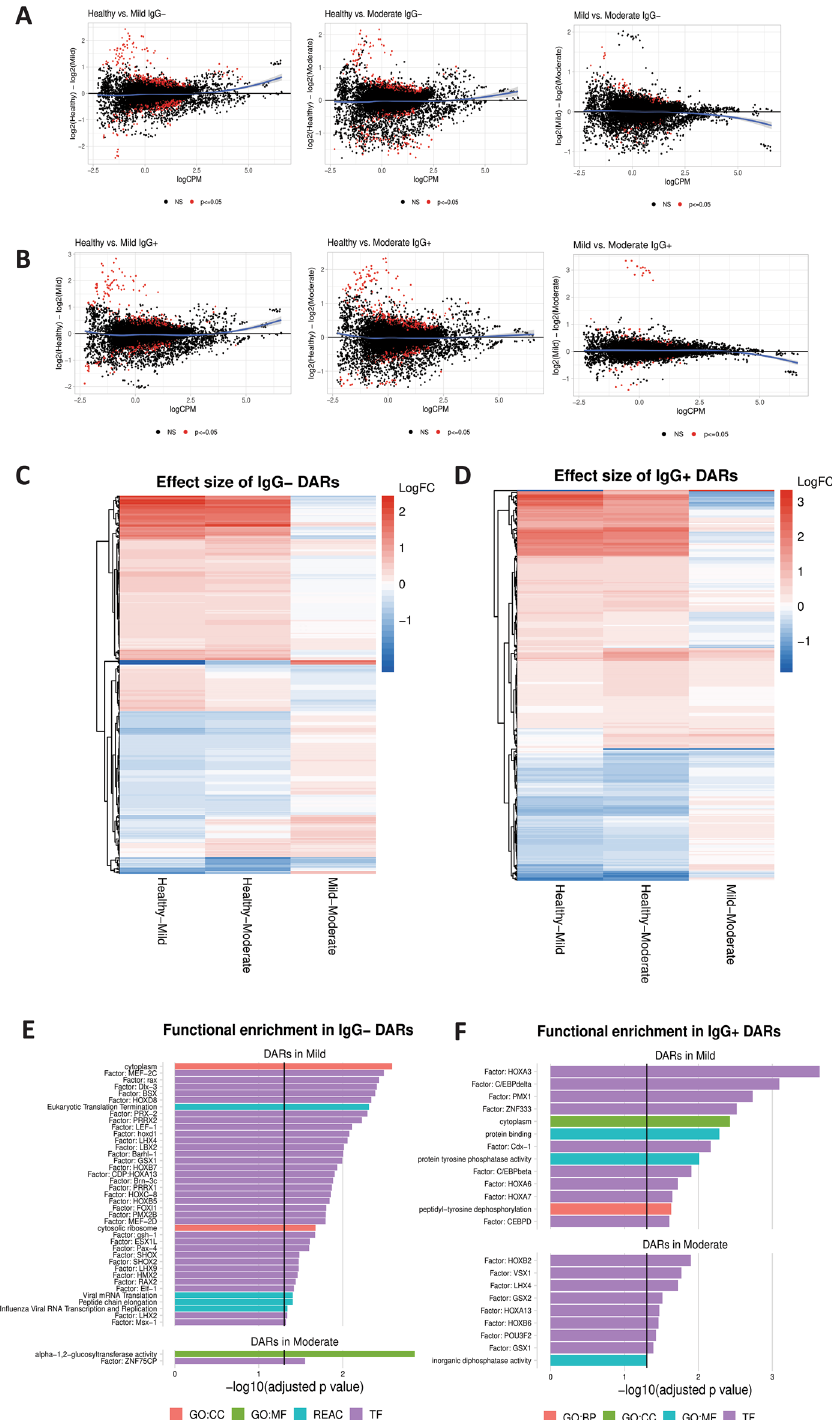
Figure 2. Remodeling of the chromatin landscape identifies gene regulatory markers associated with symptom severity. ( A ) Differential chromatin accessibility, comparing healthy controls to mild symptom IgG− subjects (left) and healthy to moderate symptom IgG− subjects (center), and IgG− mild to moderate symptoms (right). Regions that are significantly different in each comparison at p ≤ 0.05 are red; regions not significantly different are black. A loess curve fit to the results is plotted in blue. ( B ) Differential chromatin accessibility, comparing healthy controls to mild symptom IgG+ subjects (left), healthy controls to moderate symptom IgG+ subjects (center), and mild to moderate IgG+ subjects (right). A loess curve fit to the results is plotted in blue. ( C , D ) Heat map depiction of differentially accessible regions (DARs) that compares healthy to mild symptoms (left column), healthy to moderate symptoms (center column) and mild to moderate symptoms (right column) in IgG− subjects (C) and in IgG+ (D). ( E , F ) Functional enrichment analysis of DARs in the TRANSFAC database (purple), the REACTOME database (red), and gene ontologies (GO) in categories of biological processes (BP, orange), cellular component (CC, blue), and molecular function (MF, green). DARs identified comparing healthy to mild symptoms (top) or healthy compared to moderate symptoms (bottom) are shown for IgG− ( E ) and IgG+ ( F )